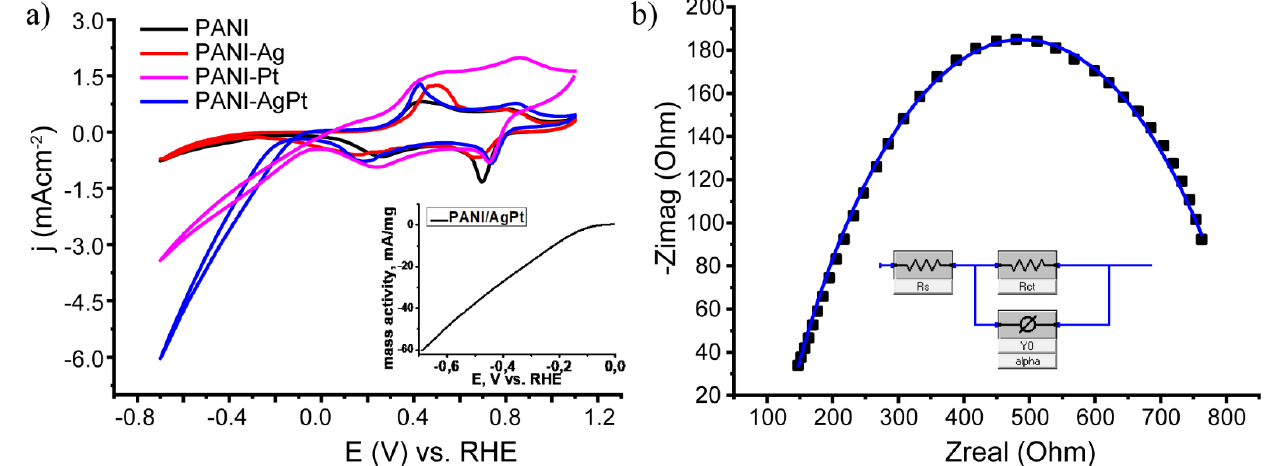
Figure 5. ( a ) CV of the obtained composites: PANI (black), PANI/Ag (red), PANI/Pt-1 (pink), and PANI/AgPt (blue); the insert shows the mass activity of the PANI/AgPt samples. ( b ) Impedance spectroscopy data for PANI/AgPt.